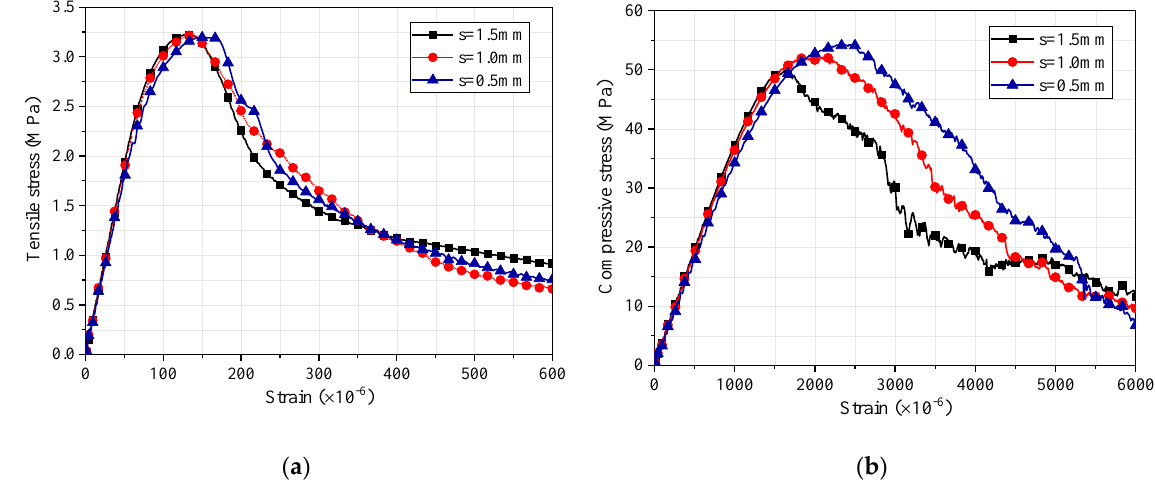
Figure 6. Effect of element size on global stress-strain relation under ( a ) tension and ( b ) compression. Table 3. Material properties of aggregate particles, mortar particles, interfacial transition zones (ITZs), and mortar internal interface (MII).